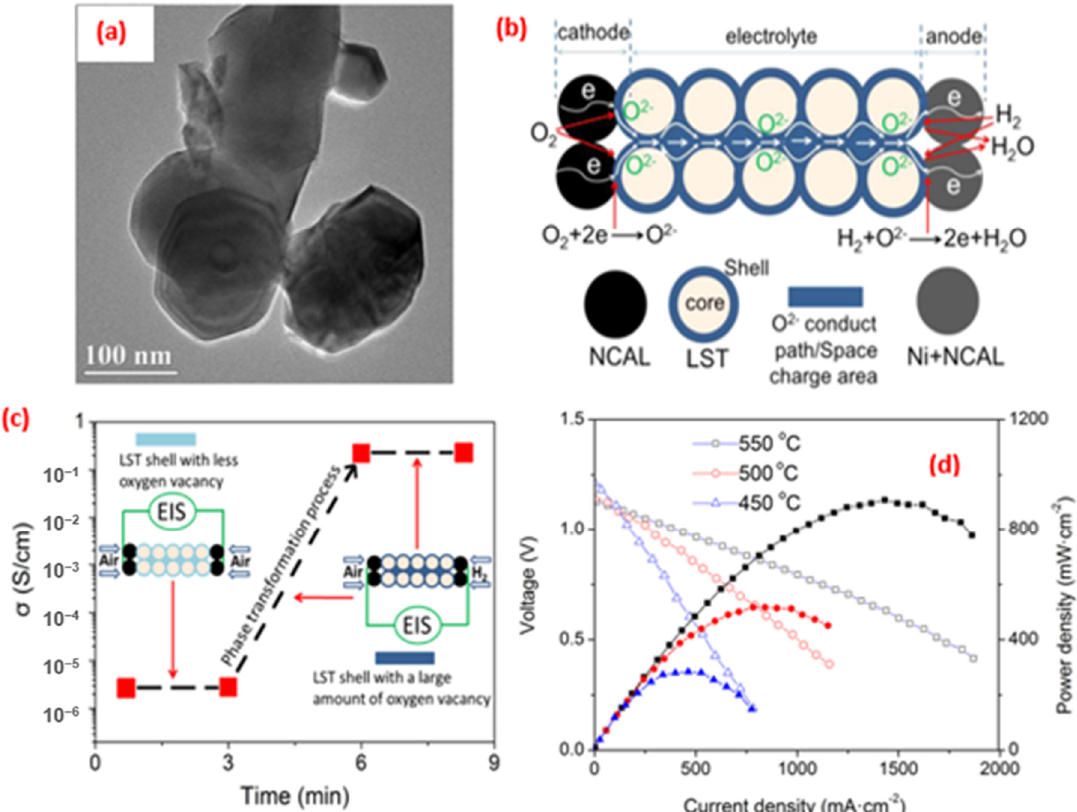
Figure 4. ( a ) TEM image of 2h La 0.25 Sr 0.75 TiO 3 powder; ( b ) the electrochemical reaction mechanism; ( c ) total electrical conductivity of the cell with the LST electrolyte in air/air and in air/H 2 ; and ( d ) current density-voltage/current density- power density curves of the cell operated at 550, 500, and 450 ◦ C in H 2 . Copyright 2018 by the American Chemical Society [75].